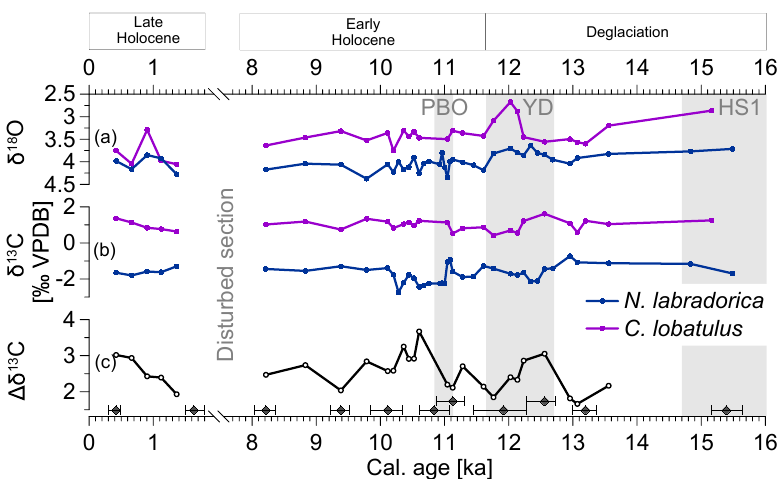
Figure 6. (a) Stable oxygen isotopes (corrected for vital effects and the global ice effect; see Sect. 3.5) and (b) stable carbon isotopes of the epibenthic species Cibicides lobatulus (purple line) vs. the endobenthic species Nonionellina labradorica (blue line). (c) Difference between epi- and endobenthic stable carbon isotope compositions. Grey vertical shadings; see Fig. 4. Dark grey diamonds: calibrated radiocarbon ages with error ranges.